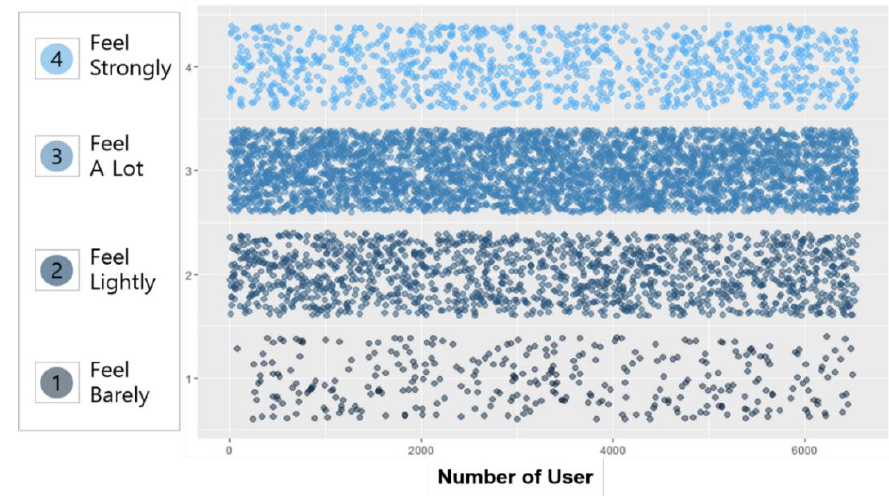
Figure 4. Scatter plot of the stress levels of users.